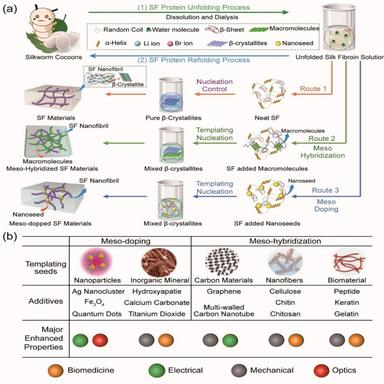
(a) Illustration of the SF protein unfolding process/refolding process and the different engineering including meso reconstruction, meso doping and meso hybridization. Reproduced with permission . Copyright 2021, Wiley-VCH. The key structural factors that mostly influence the macroscopic mechanical performance of SF materials. (b) Brief summary of templating seeds used to functionalize mesoscopic flexible SF materials via meso-doping and meso-hybridization and the potentially enhanced properti